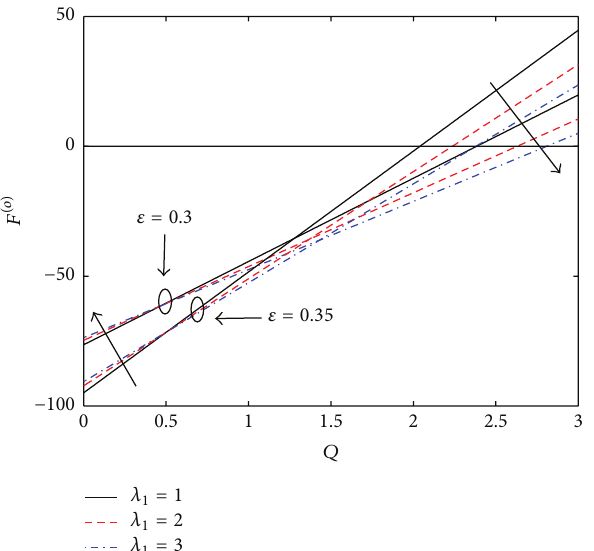
Figure 12: Frictional force on the outer tube 𝐹 (𝑜) versus the time- averaged flow rate 𝑄 for different values of the relaxation time 𝜆 1 and radius ratio 𝜀 with Gr = 3 , 𝛼 1 = 0.4 , 𝛽 = 10 , 𝜙 = 0.4 , and 𝑡 = 1 .